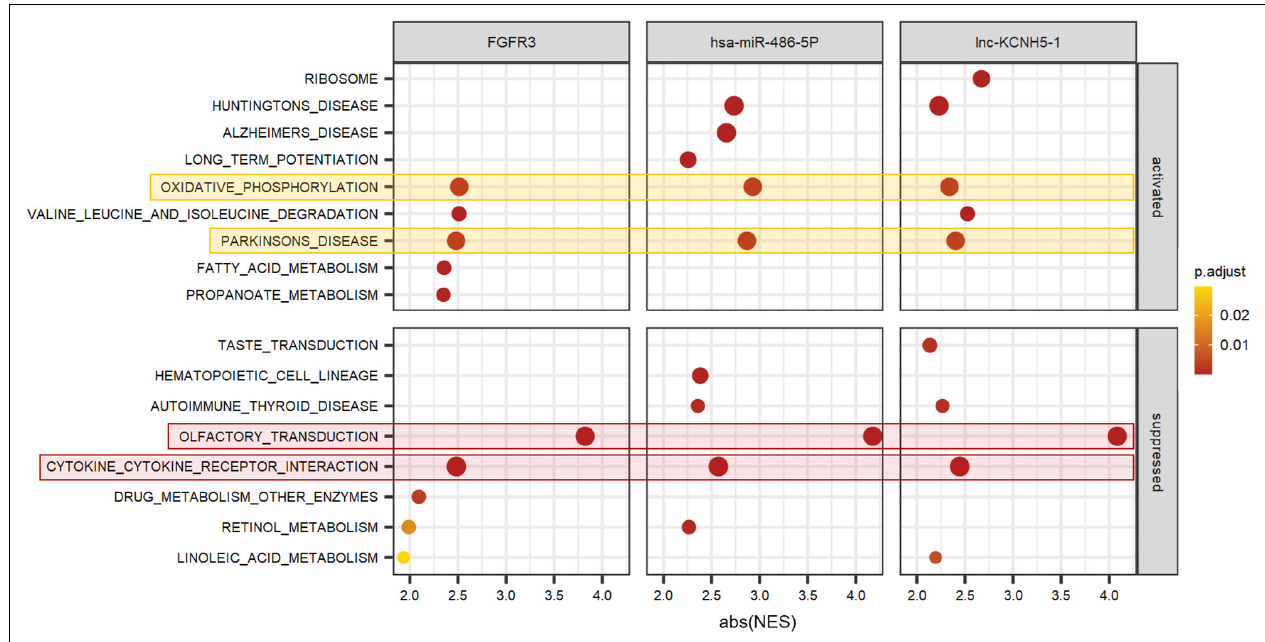
FIGURE 6 | Function prediction of FGFR3, hsa-miR-486-5P, and lnc-KCNH5-1 by GSEA. GSEA terms were ordered according to their ranked abs (NES). GSEA, Gene set enrichment analysis; NES, normalized enrichment